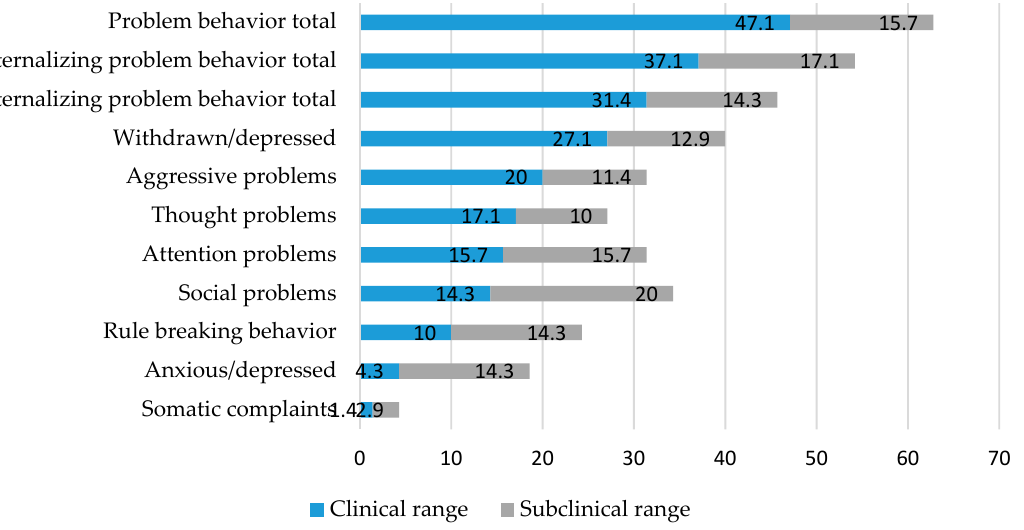
Figure 3. The presence of (sub)clinical problem behavior reported by residential care mentors in children with ID. CBCL: Child Behavior Checklist.